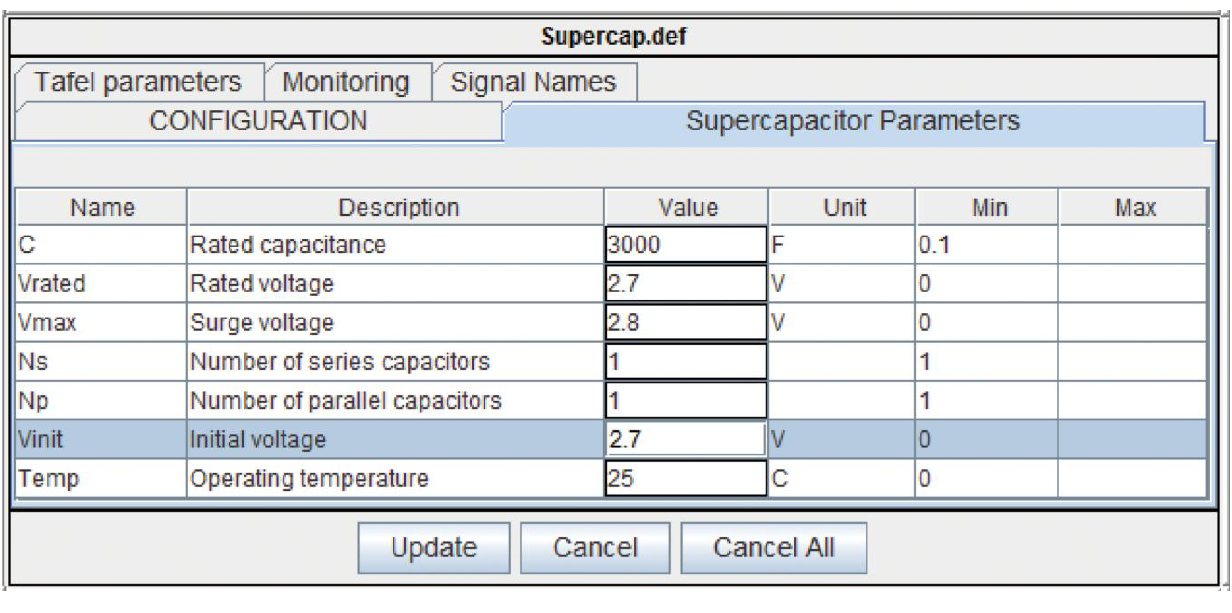
Figure 4. EDLC model parameter configuration